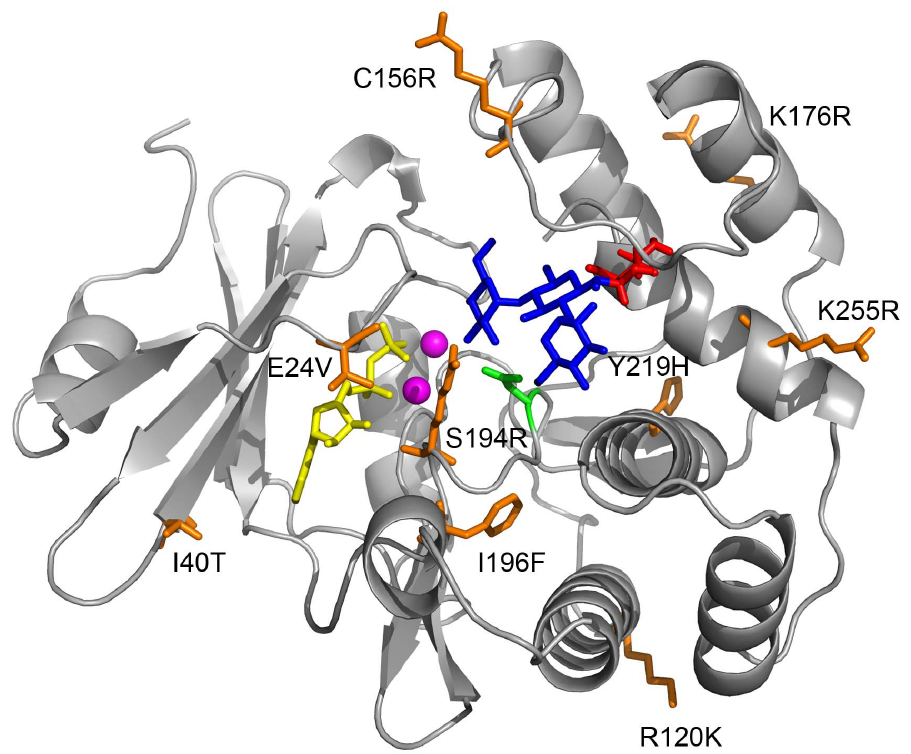
Figure 1. Model of artificially evolved aminoglycoside phosphotransferase (3 9 )-IIIa, based upon crystal structure (1L8T) of the wild- type enzyme [ 23 ] rendered in PyMOL. The putative beneficial mutations are colored orange, the catalytic D190 residue is green), adenosine diphosphate is yellow and magnesium is pink. Kanamycin is blue, while the ‘‘extra’’ moiety that differentiates amikacin from kanamycin is red.